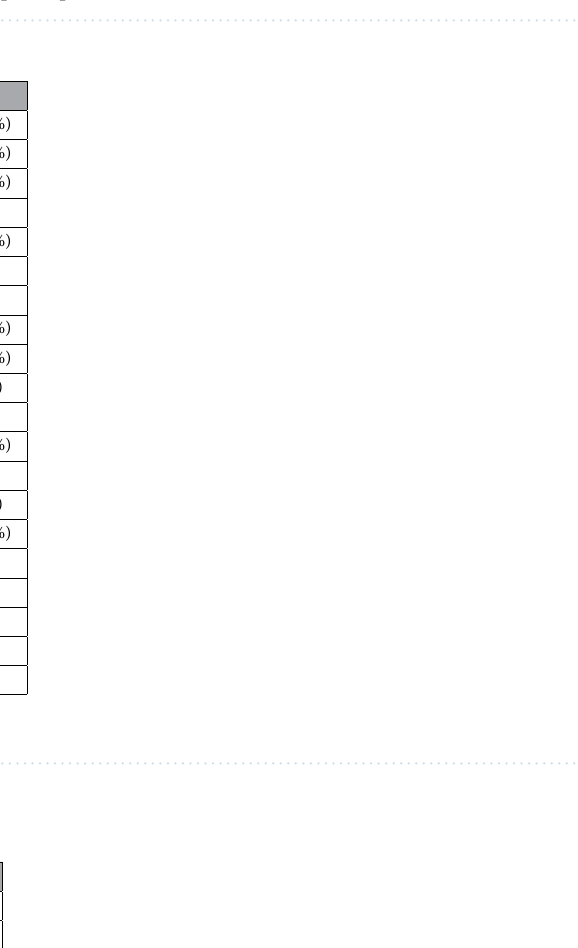
Table 2. Clinical characteristics of the study participants. + n = 124.